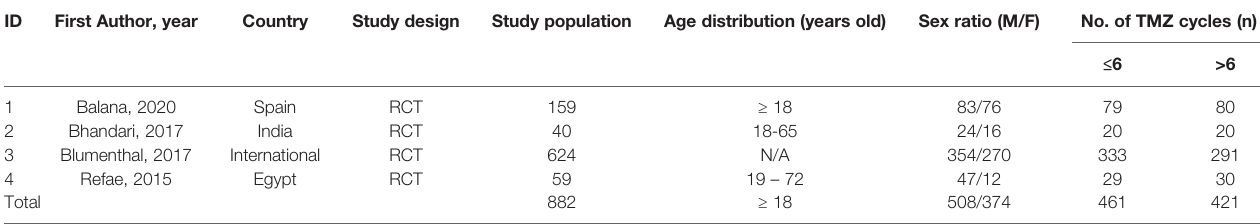
TABLE 2 | Main characteristics of four studies included in the current